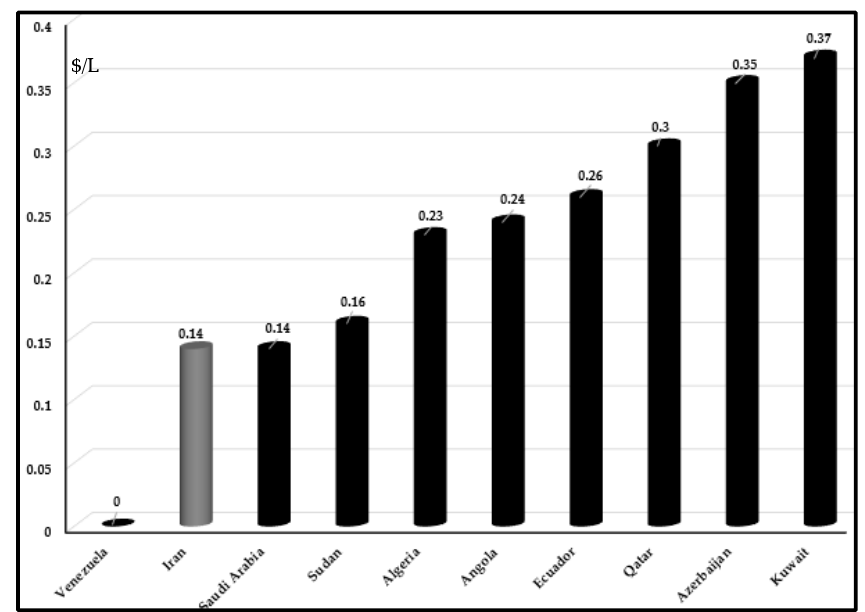
Figure 7. Top ten world’s lowest diesel price 13 July 2020 [40].